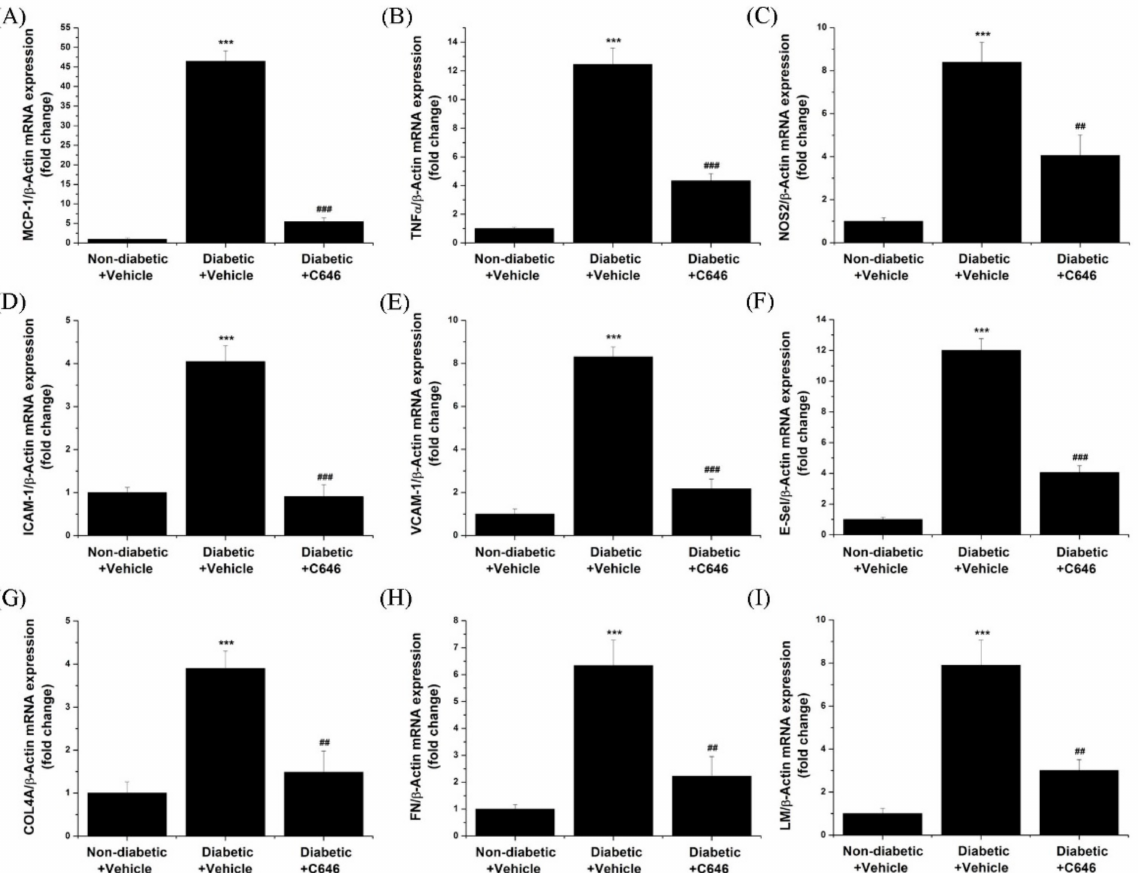
Figure 6. Quantitative real-time PCR analysis indicating the down-regulatory effects of C646-induced p300/CBP inhibition on diabetes-induced augmented mRNA levels of ( A ) MCP-1, ( B ) TNF α , ( C ) NOS2, ( D ) ICAM-1, ( E ) VCAM-1, ( F ) E-selectin, ( G ) collagen IV/COL4A, ( H ) fibronectin/FN, and ( I ) laminin/LM. n = 3–4, *** p < 0.001, p -values taken in relation to vehicle-treated non-diabetic mice condition; ## p < 0.01, ### p < 0.001, p -values taken in relation to vehicle-treated diabetic mice